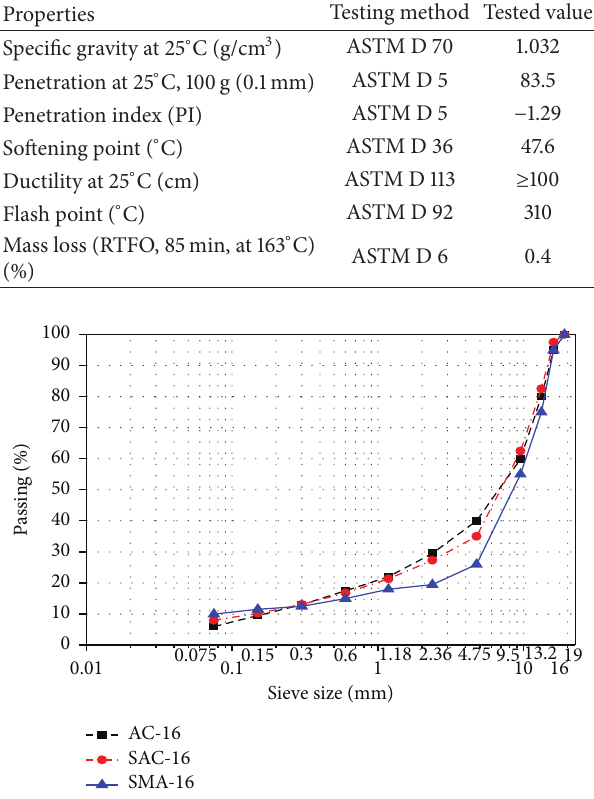
Figure 5: Gradation curves of three types of